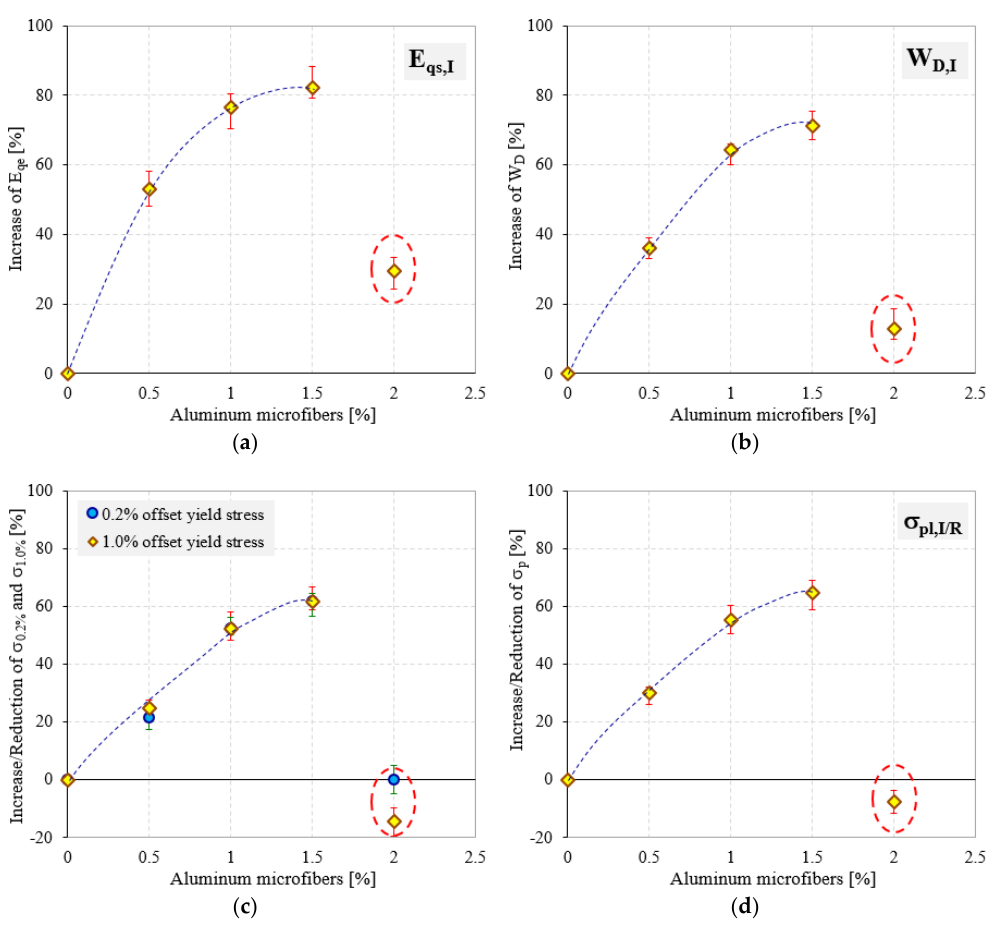
Figure 6. Percentage increase/decrease of the quasi-elastic gradient ( a ); energy absorption ( b ); 0.2 and 1% offset yield stresses ( c ) and plateau stress ( d ) for modified semi-rigid PU foam samples normalized by reference PU foam (0% AMs).